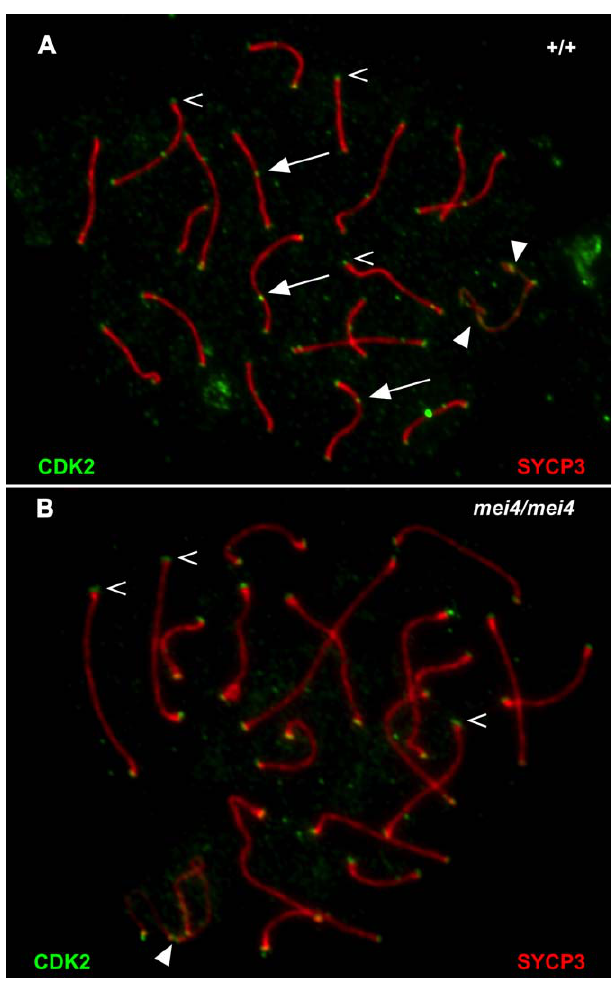
Figure 6. CDK2 Does Not Localize to Interstitial Sites on Synapsed mei4/ mei4 Bivalents during Pachynema (A) Wild-type ( þ / þ ) spermatocyte chromosome spread labeled with antibodies against CDK2 (green) and SYCP3 (red). CDK2 localizes to telomeric foci (open arrowheads), along the asynapsed axes of the sex chromosomes (closed arrowheads), and at interstitial sites (white arrows) along synapsed wild-type bivalents in pachynema. (B) mei4/mei4 spermatocyte chromosome spread labeled as in (A) showing absence of CDK2 localization at interstitial loci. Despite loss at interstitial sites, CDK2 localization is observed at telomeric foci (open arrowheads) and at loci along the sex chromosomes (closed arrowheads).